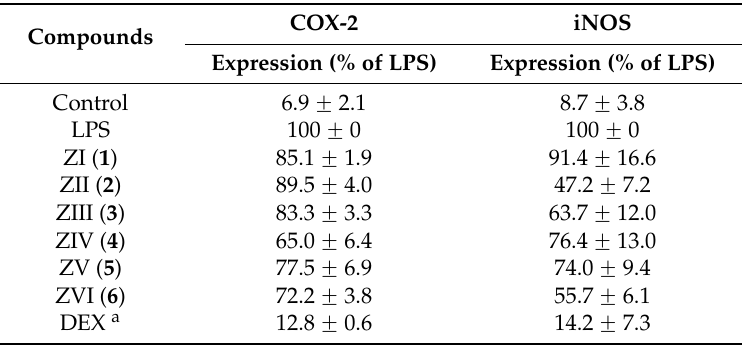
Table 7. The effect of briarenolides ZI–ZVI ( 1 – 6 ) on LPS-induced COX-2 and iNOS protein expression in